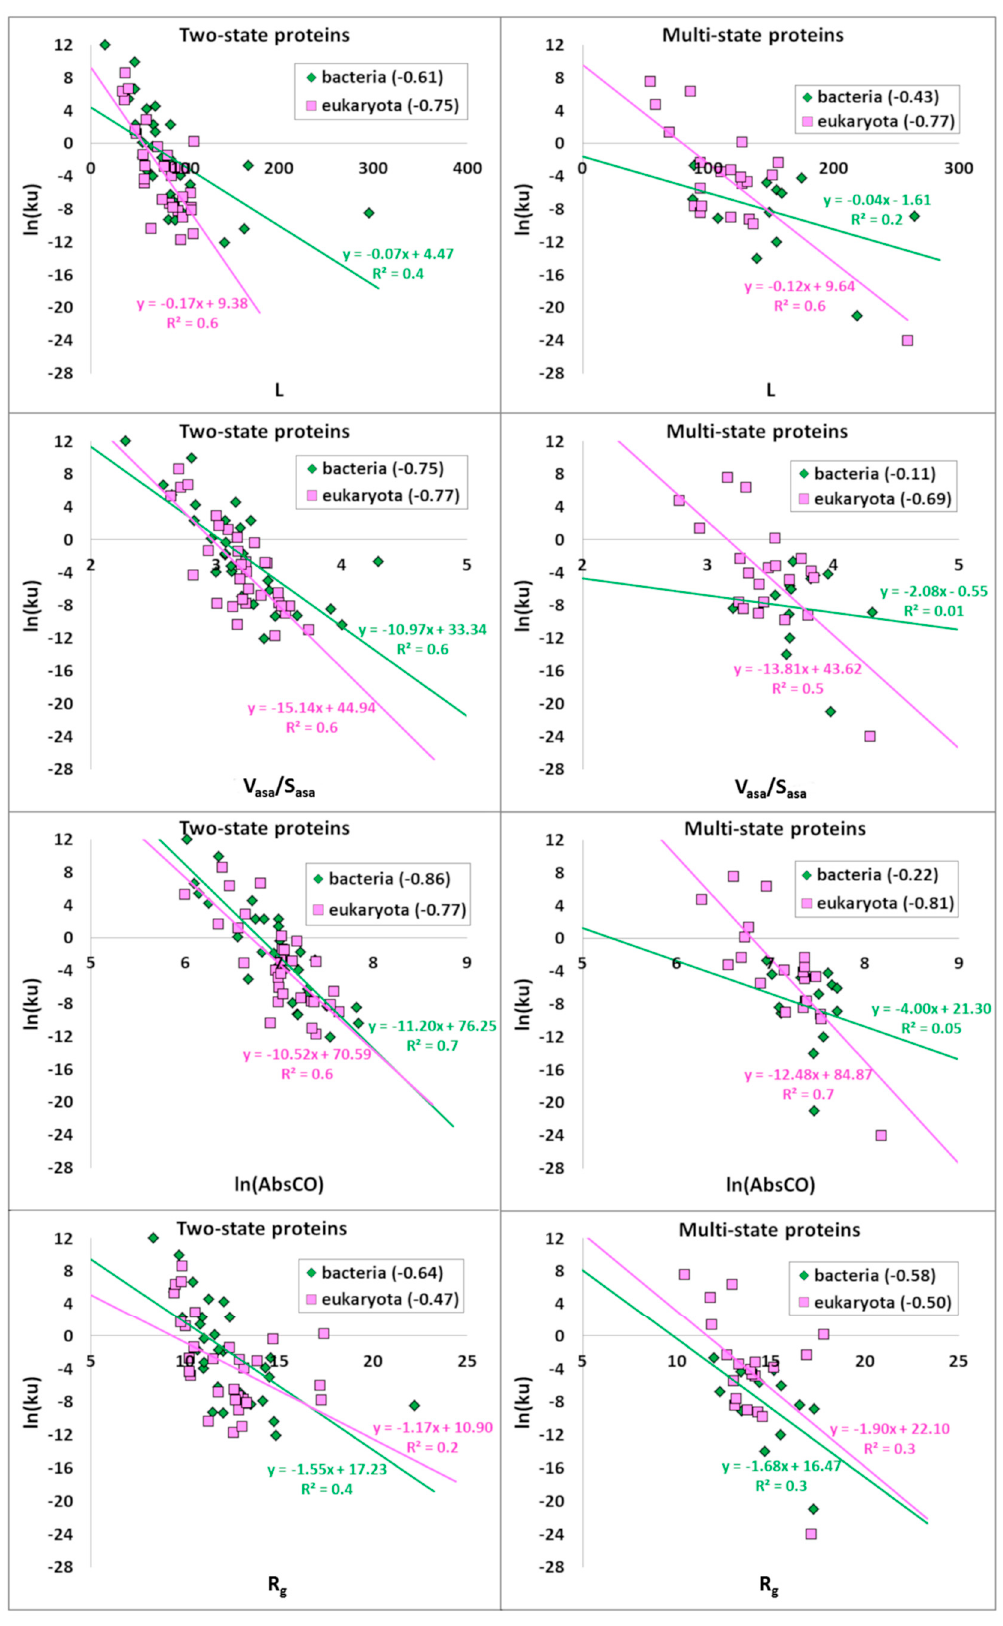
Figure 4. Correlations of the logarithm of the unfolding rate of the two- and multi-state bacterial and eukaryotic proteins with structural parameters: L, V asa / S asa , ln(AbsCO), and R g . There is a line approximation of points and its equation: green line corresponds to bacterial proteins and pink line to eukaryotic proteins. R 2 is a linear approximation reliability.